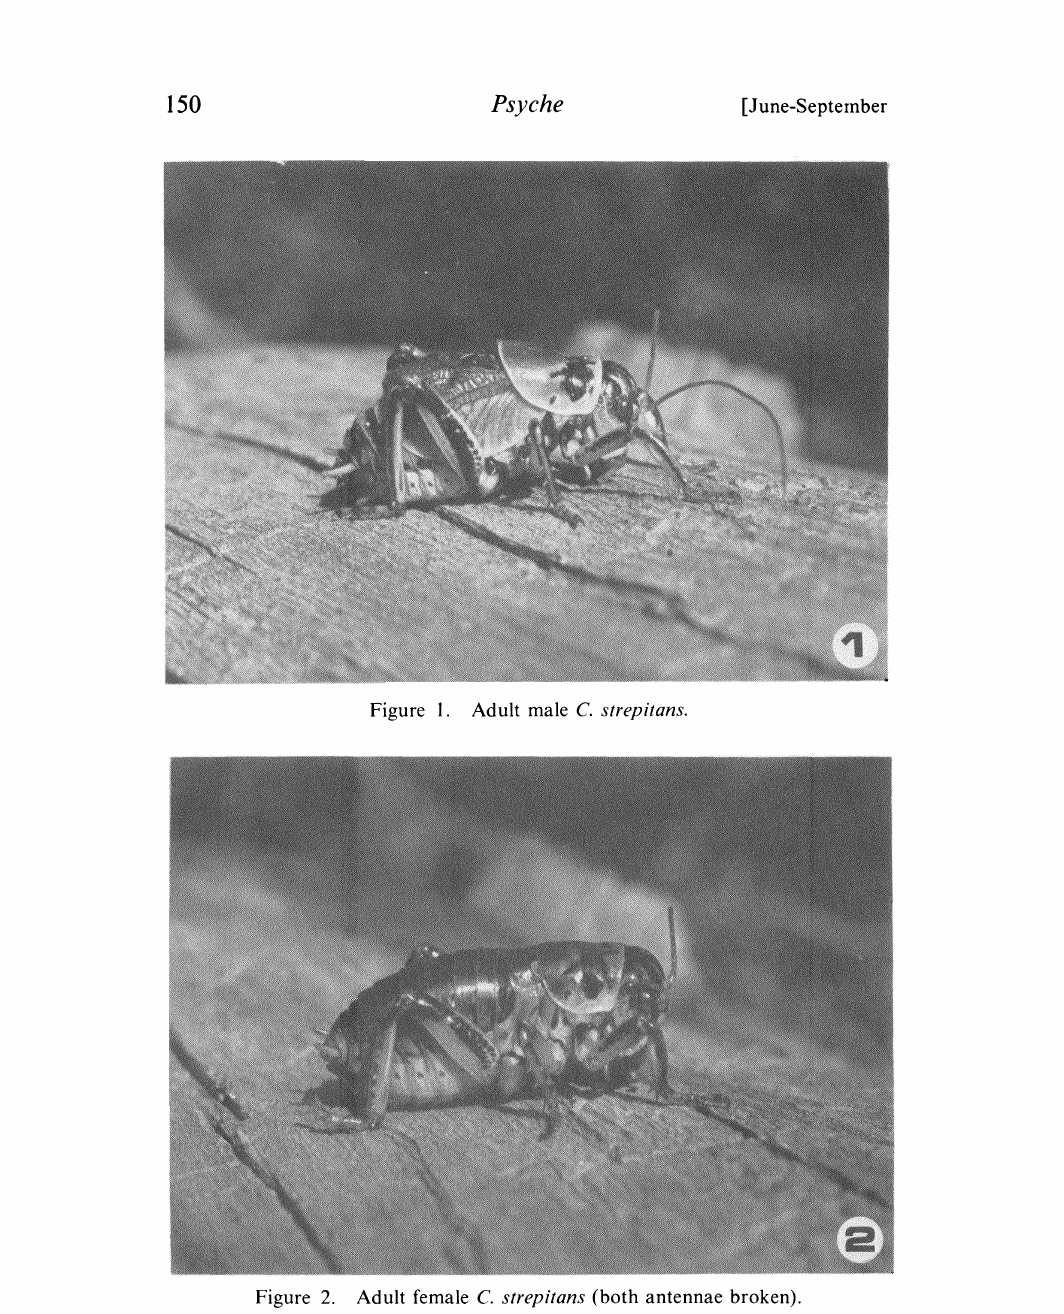
Figure 2. Adult female C. strepitans (both antennae